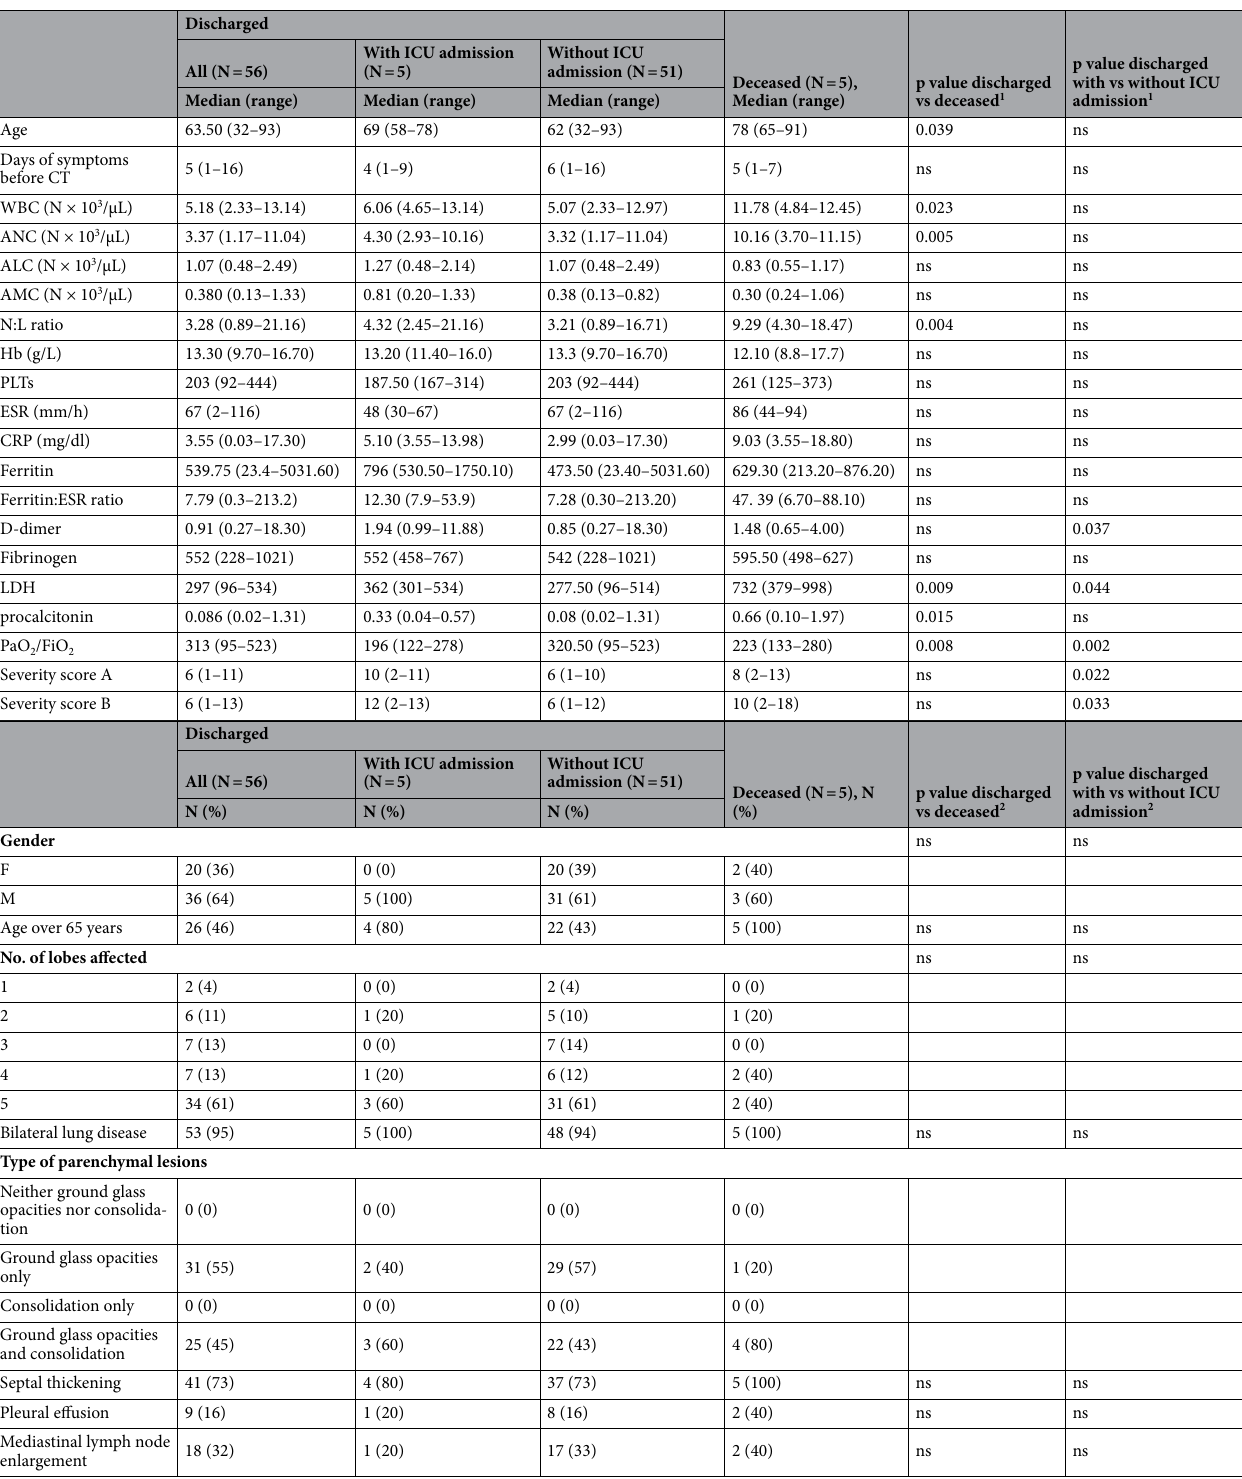
Table 5. Characteristics of patients according to the outcome. CT computer tomography, ICU intensive care unit, SD standard deviation, WBC white blood cells, ANC absolute neutrophil count, ALC absolute